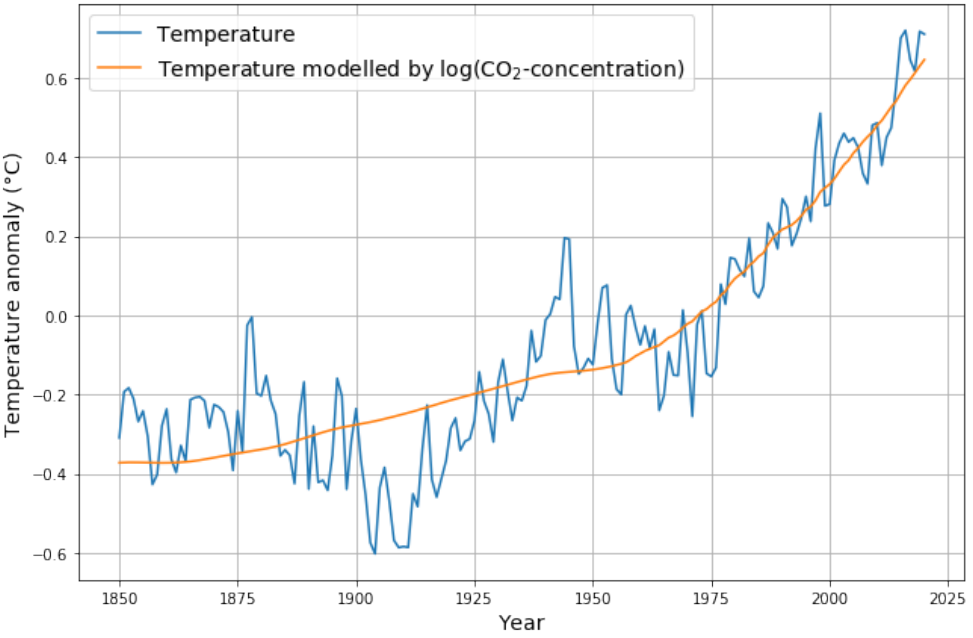
Figure 3. CO 2 concentration as a proxy for global